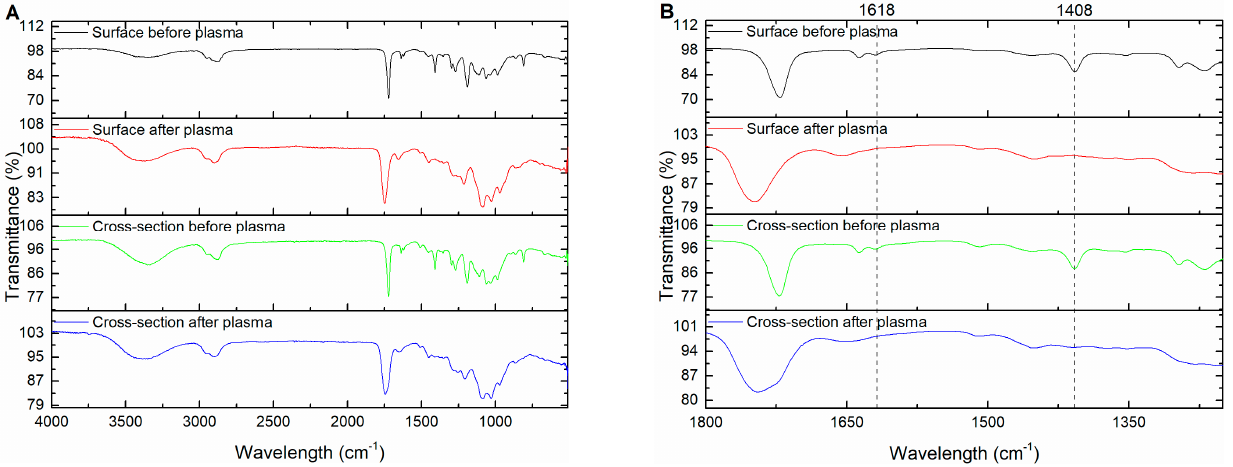
Figure 4. FTIR spectra for the surface and cross ‐ section of the WPCs before and after plasma treat ‐ ment. ( A ) Full range FT ‐ IR spectra. ( B ) Truncated FT ‐ IR spectra with signature bands annotated. ( A ) Full range FT-IR spectra. ( B ) Truncated FT-IR spectra with signature bands